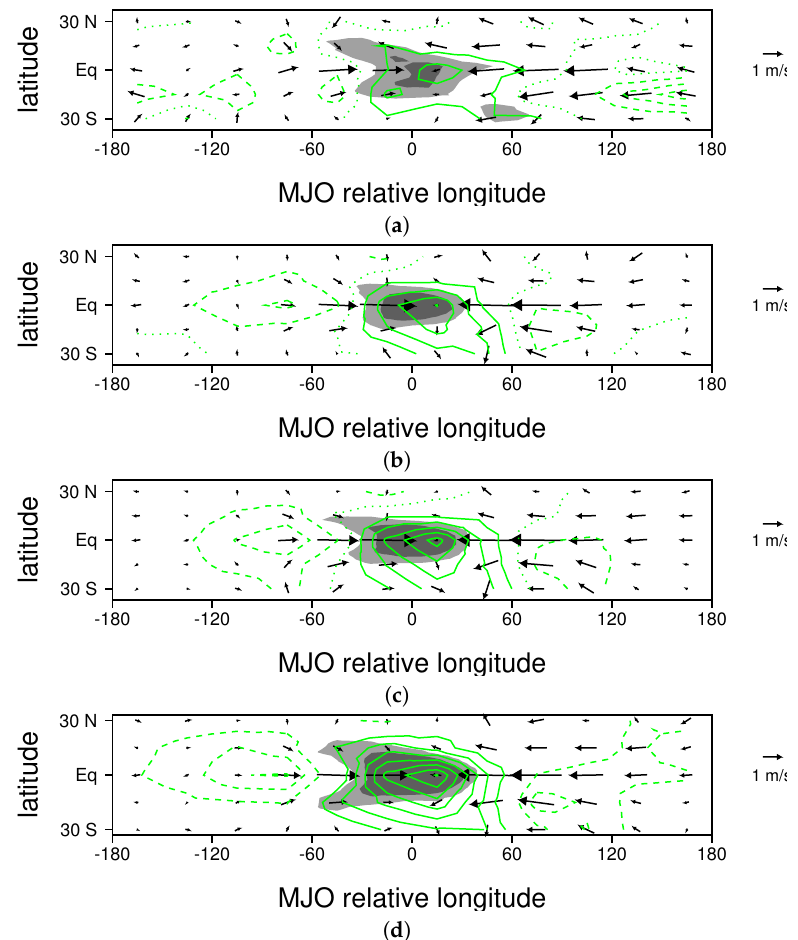
Figure 4. Composite horizontal structure of 850 hPa wind perturbations (vectors) and precipitable water perturbations (green contours, 1 mm/day contour interval) for the mature stage of the MJO for: ( a ) observations; ( b ) the control run; ( c ) the 3 K warming experiment; and ( d ) the 7 K warming experiment. The contour interval is 1 mm, the zero contour is dotted, and negative contours are dashed. Regions with precipitation perturbations greater than 1 (3) mm/day are shaded light (dark)